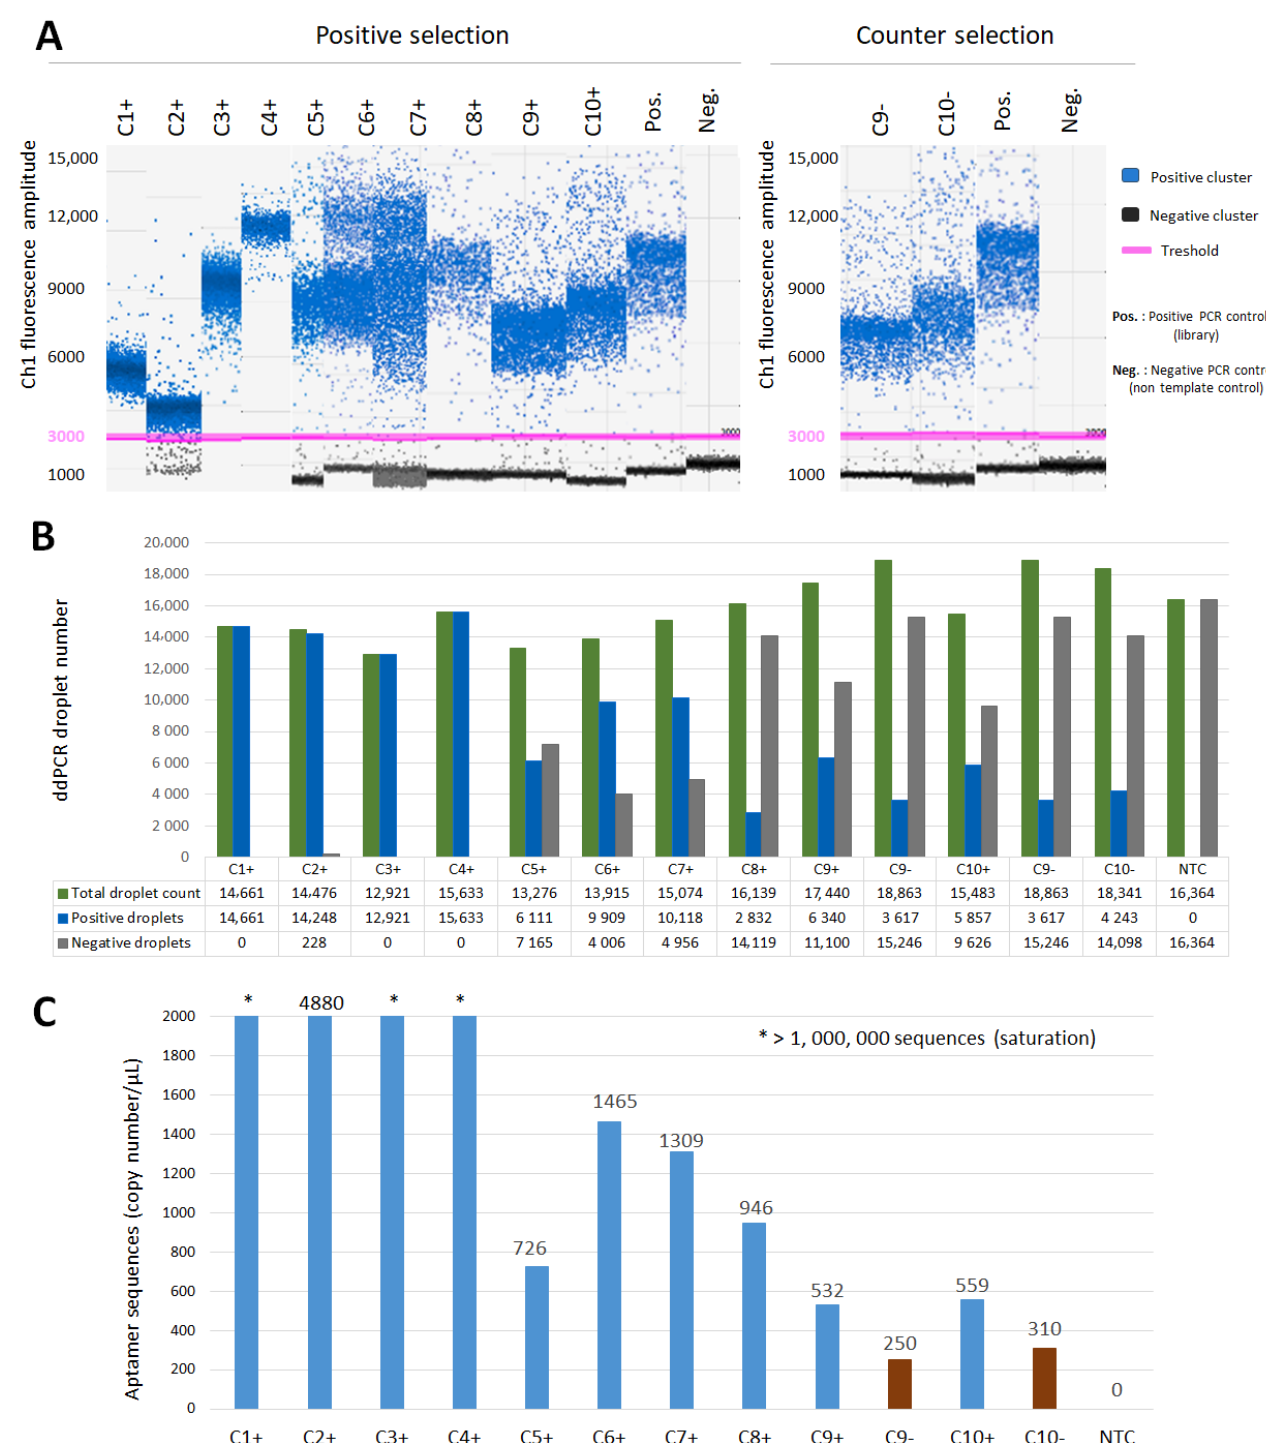
Figure 2. Digital droplet PCR analysis of aptamers recovered during Hi-Fi SELEX to ovarian cancer biomarker HE4. ( A ) 1-D plot of Hi-Fi SELEX positive selection to target HE4 protein and counter selection to 6xhistidine peptide. Many sequences were detected in all cycles of selection. In the plot, each droplet from a sample in each SELEX cycle is plotted on the graph of the fluorescence intensity vs. droplet number. All positive droplets with anti-HE4 aptamer present (in blue), are those above the pink threshold line and are scored as positive. All negative droplets are those without target aptamers present (in dark gray) below the red threshold line and scored as negative. ( B ) ddPCR droplet enumeration throughout Hi-Fi SELEX positive and negative selection. The droplets